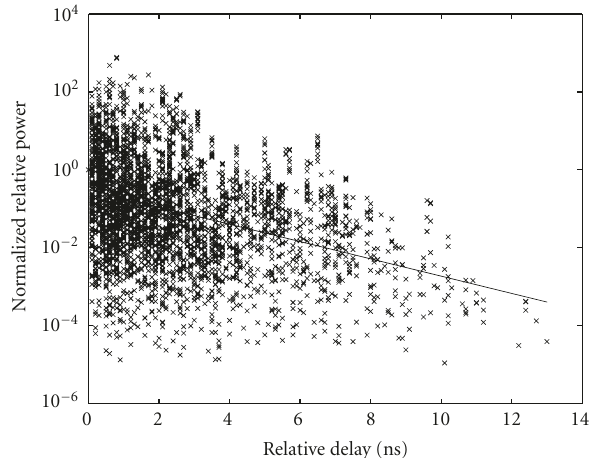
Figure 24: Normalized path power decay for measurements from the Escalade engine